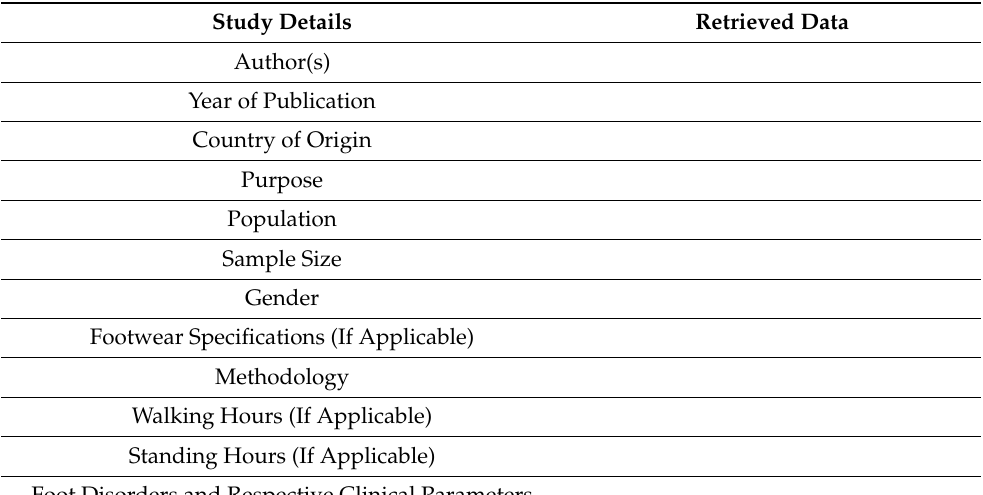
Table 2. Data extraction